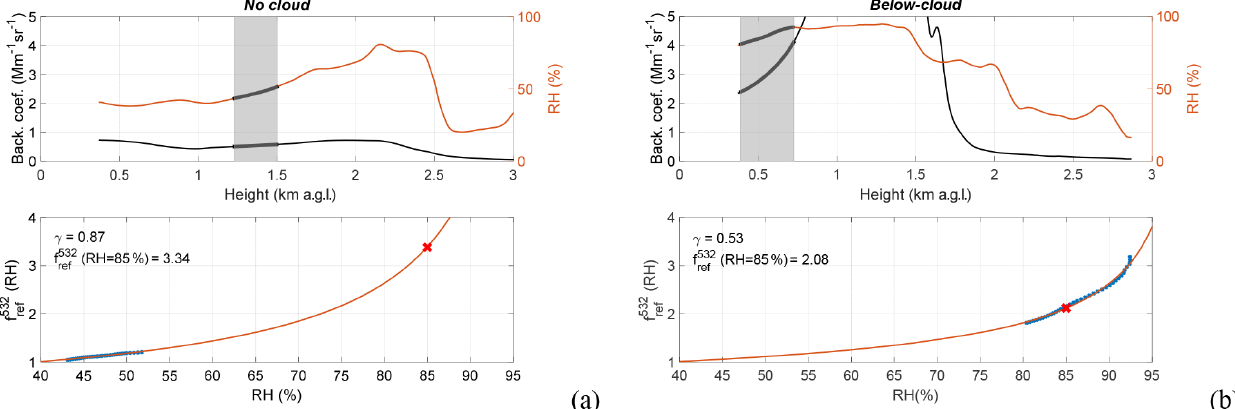
Figure 8. (a) No cloud and (b) Below-cloud cases; (top) backscatter coefficient (black, left axis) and relative humidity (red, right axis) versus height; (bottom) f 532 at RH = 85% and RH ref = 40% (blue crosses) and Hänel fit (red line). In the top plots the hygroscopic layer ref is reported in a shaded rectangle and thicker lines.